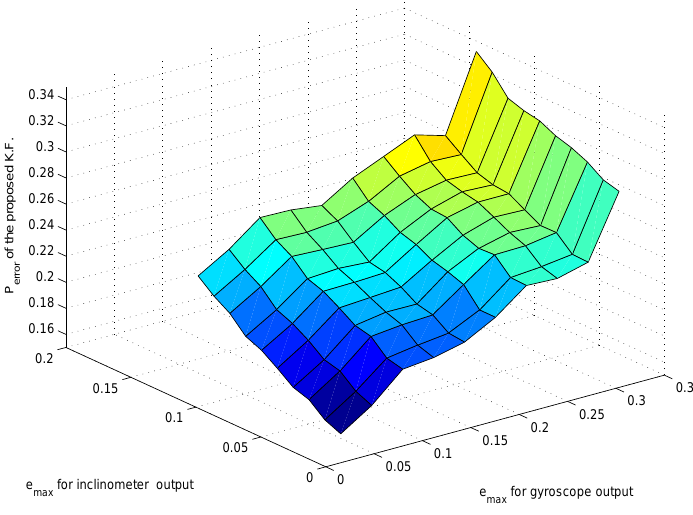
Figure 8. Estimation error (